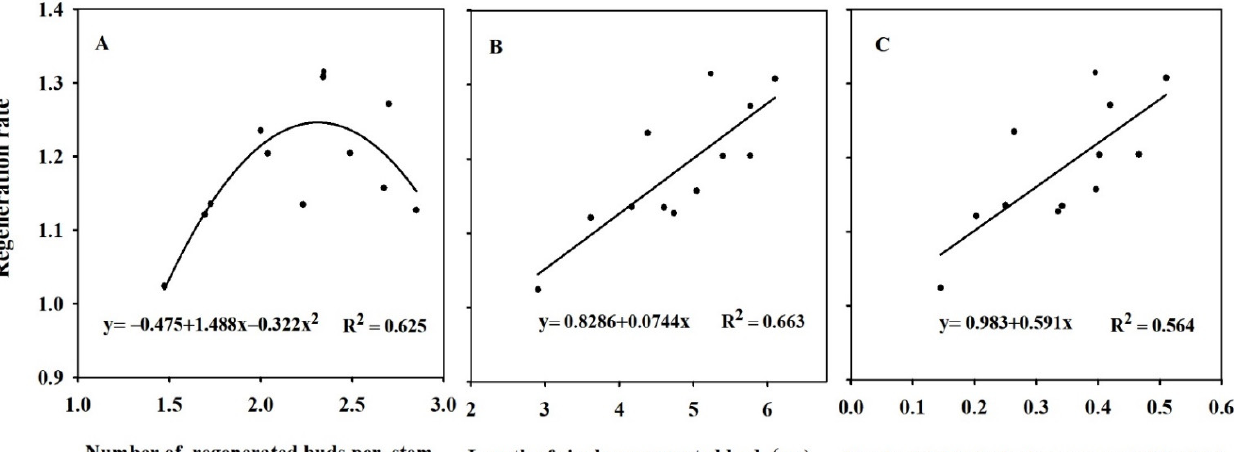
Figure 4. Relationships between the number ( A ), length ( B ), and fresh weight ( C ) of regenerated buds at maturity of the main crop and the regeneration rate.